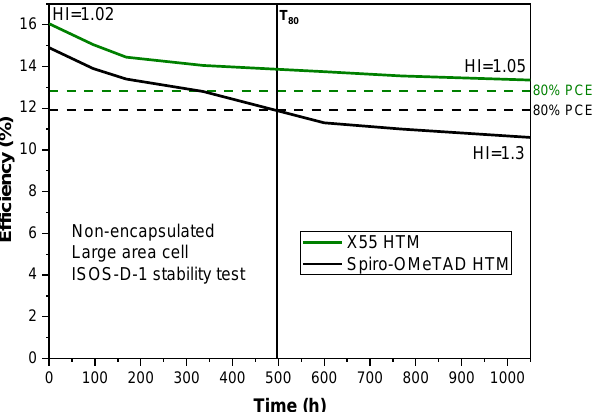
Figure 6. Efficiency trend according to ISOS-D-1 standard (relative humidity of around 50%) of nonencapsulated large area devices.